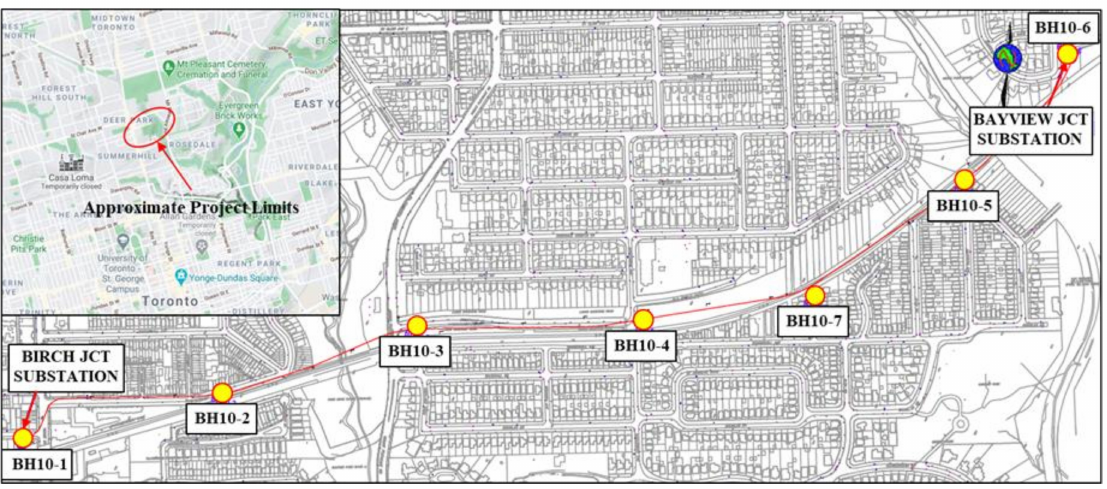
Figure 1. Detailed site and borehole